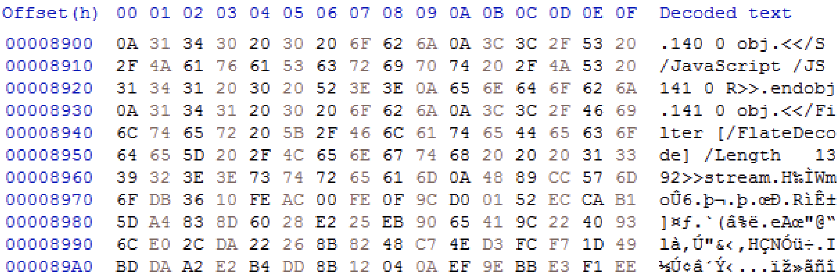
Figure 7. Raw bytes and text strings of a normal PDF file displayed by HxD.